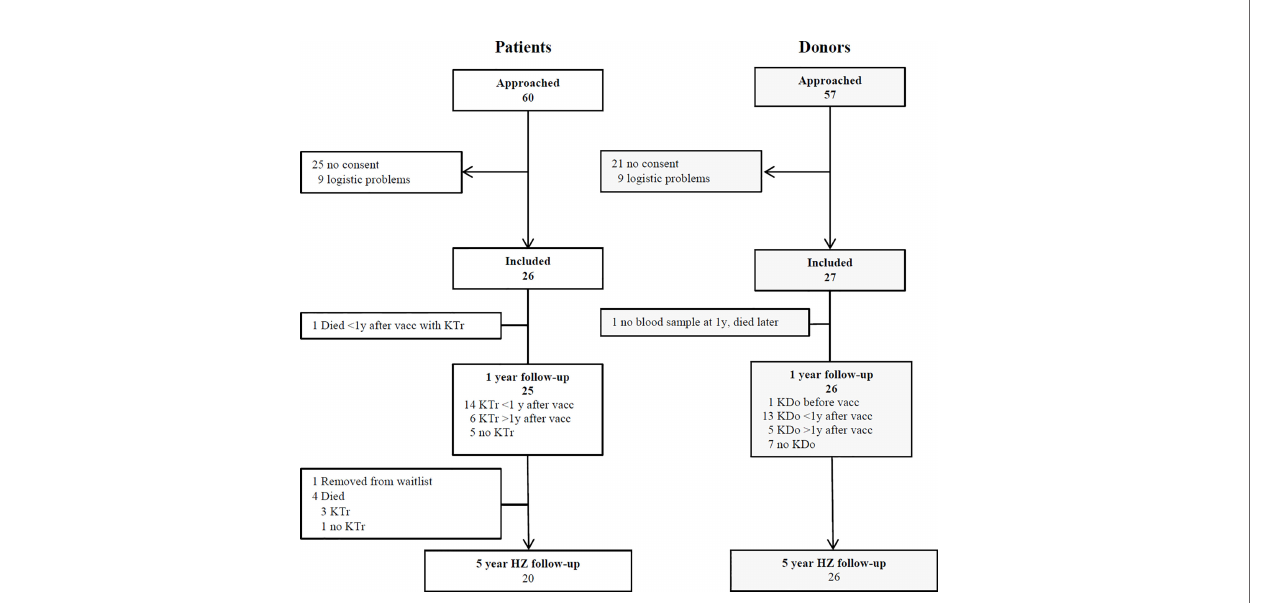
FIGURE 1 | Participants enrolment and follow-up. KTr= kidney transplant. KDo= kidney donation. HZ= herpes zoster. Vacc= vaccination. Eligible, potential participants were approached at the outpatient clinic and by telephone call from the investigators. They received both oral and written information. Some participants could not be included due to a tight schedule of transplantation and donation and/or temporary unavailability of the vaccine.